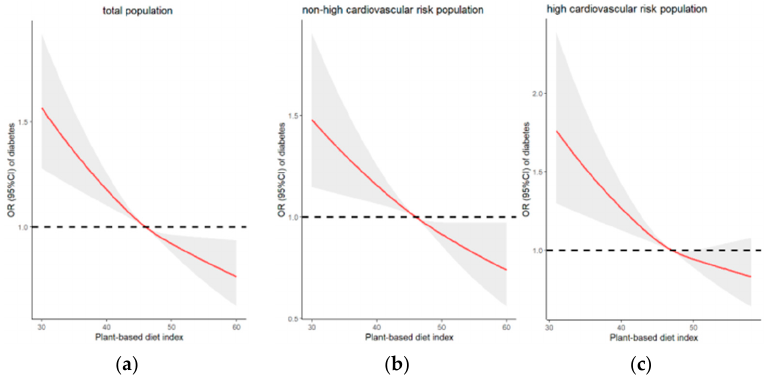
Figure 2. Multivariable-adjusted odds ratios (ORs) and 95% confidence intervals (CIs) for T2D risk based on the continuous PDI in three different populations adjusted for a series of covariates in Model 3. ( a ) Association between PDI and T2D risk in total population ( b ) Association between PDI and T2D risk in non-high cardiovascular risk population (non-HCRP) ( c ) Association between PDI and T2D risk in high cardiovascular risk population (HCRP). The shaded area represents 95% confidence intervals. The red lines indicate the multivariable-adjusted ORs for T2D risk. The dotted lines are the median value as a reference group, corresponding to an OR of 1.0.